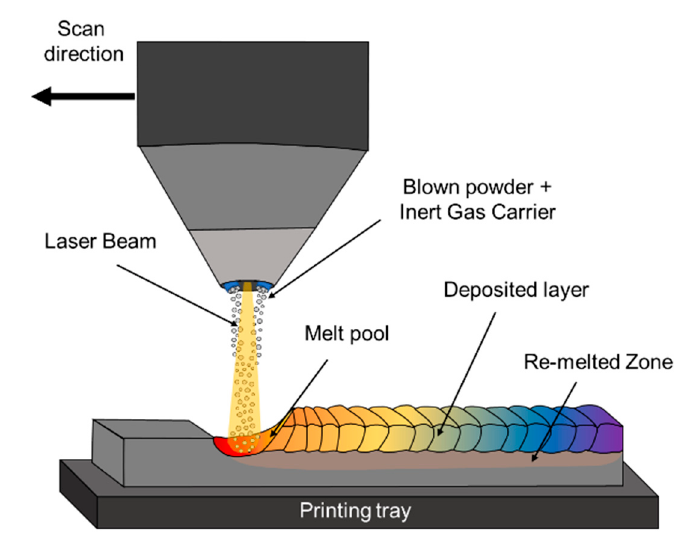
Figure 10. Schematic illustration of blown powder deposition (BFD)